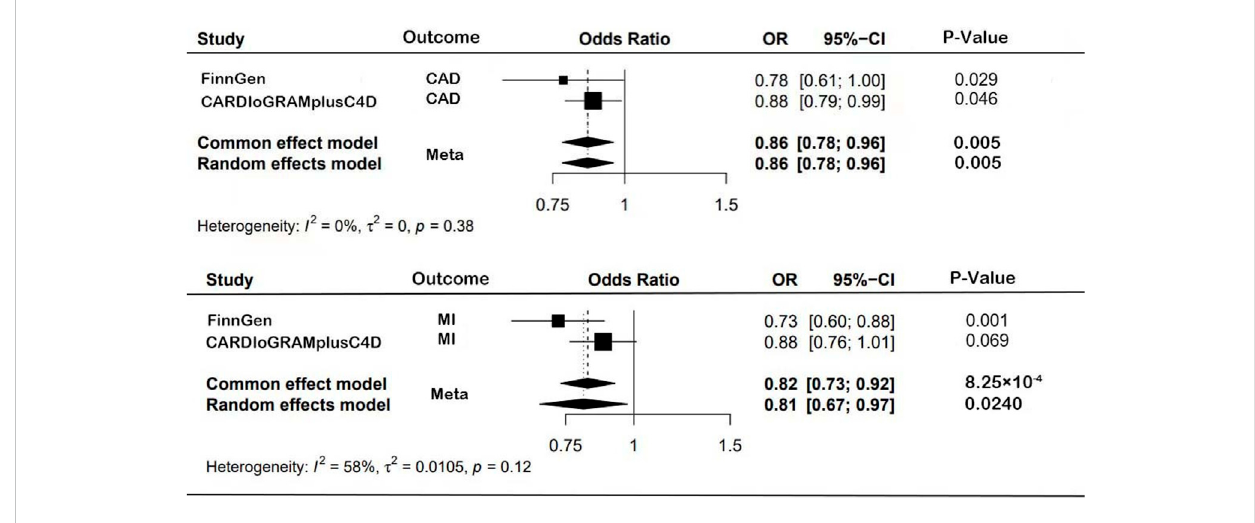
FIGURE 3 Forest plot results from MR